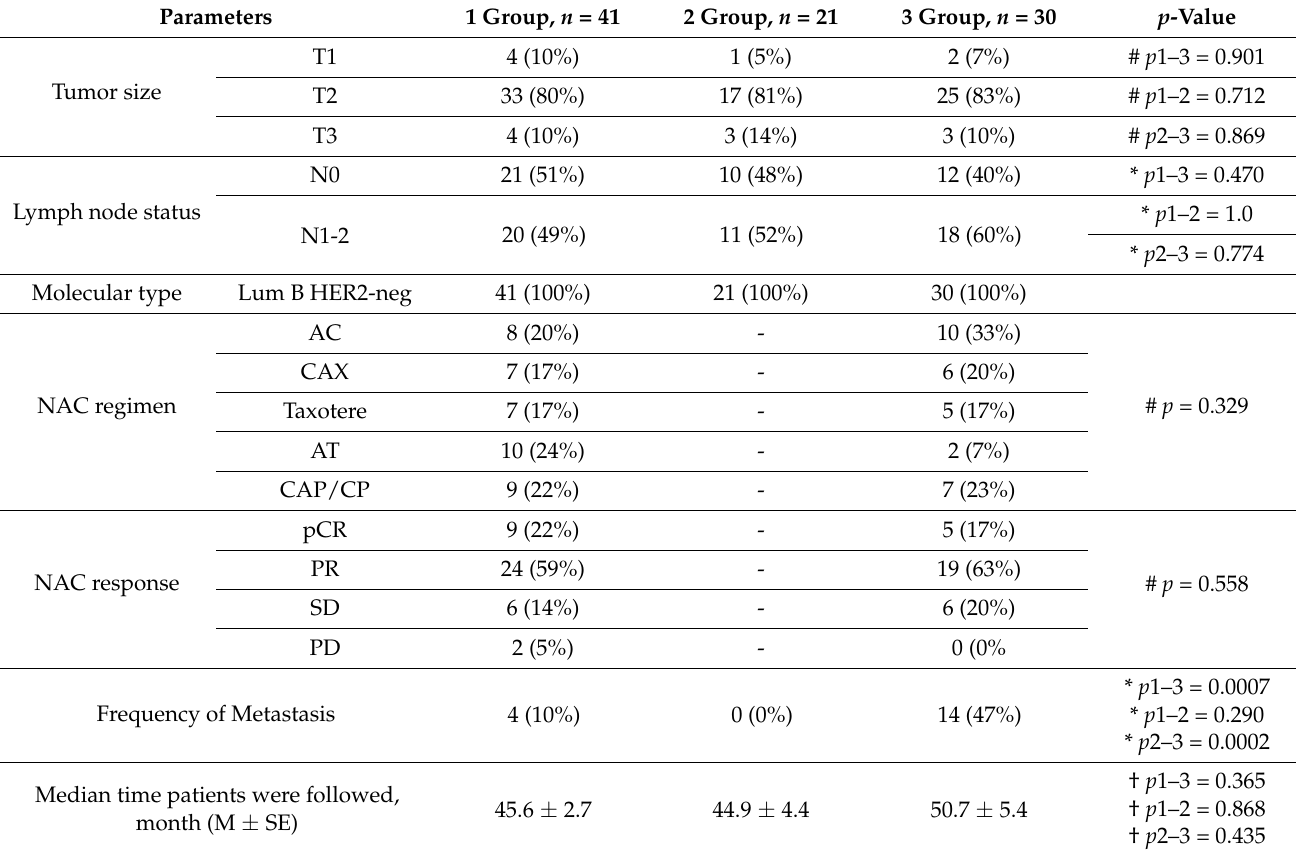
Table 1. Comparison of clinical indicators of patients in prospective study